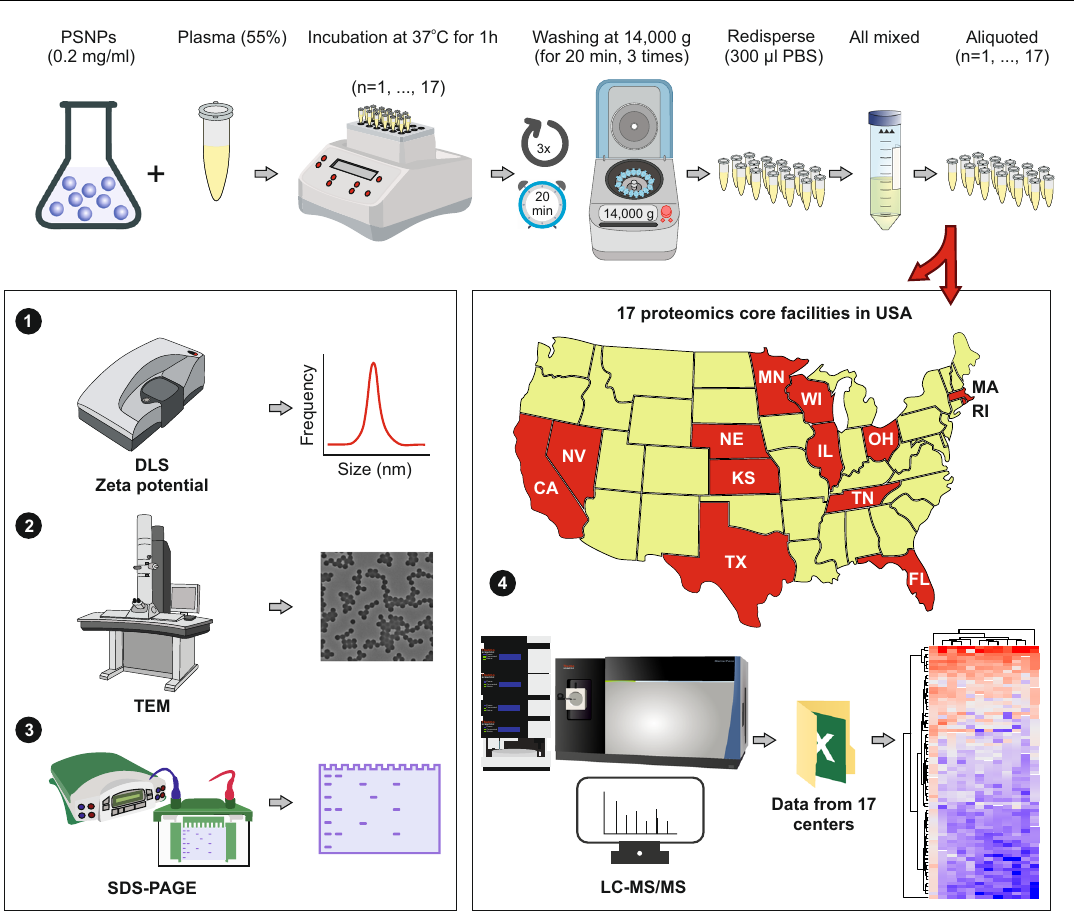
Fig. 1 | Schematic representation of the study. After formation of the protein corona-coated polystyrene NPs (PSNPs), 17 similarly prepared batches were char- acterized individually and shipped to various proteomics core facilities across the USA to investigate the homogeneity/heterogeneity of the proteomics data retrieved on the protein corona pro fi le on the surface of NPs. PSNPs